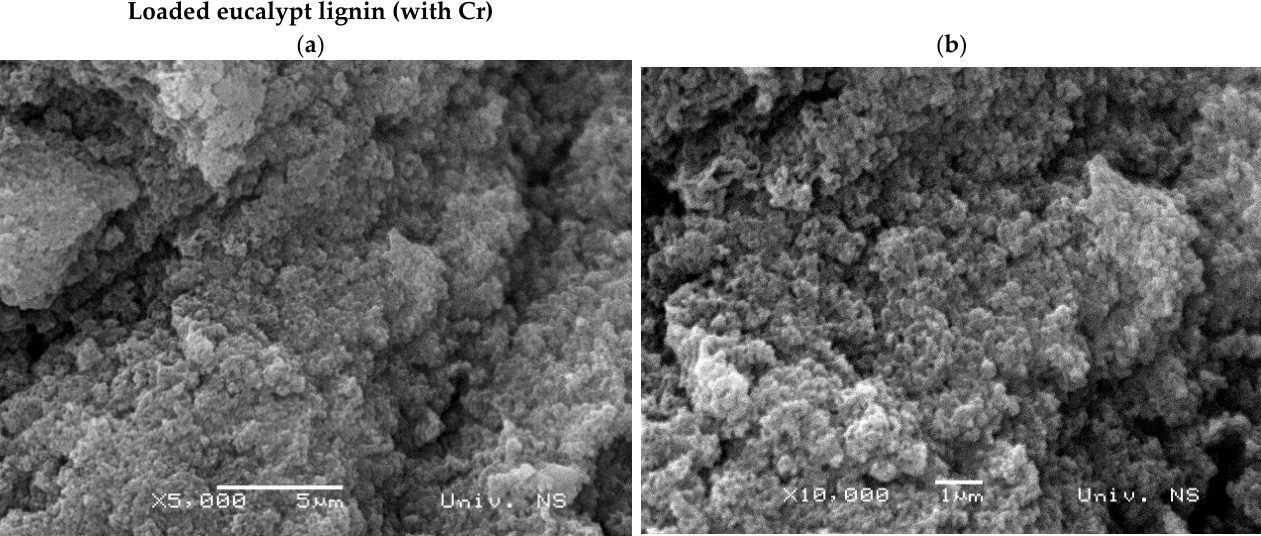
Figure 10. SEM images of the eucalypt stump and kraft lignin after adsorption of Cr(VI) ions. Mag- nification scales: ( a , c )—×5000; ( b , d )—×10,000.